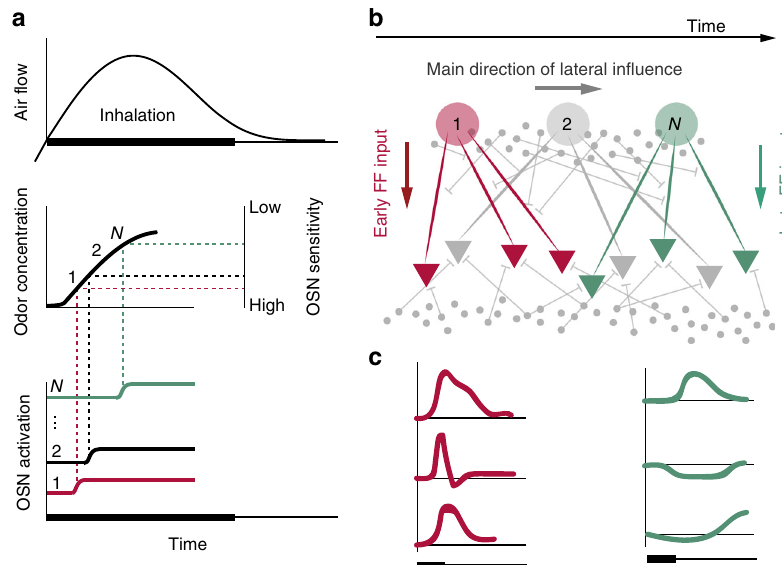
Fig. 8 A proposed mechanism responsible for stereotypy/diversity among sister MT cell odor responses. a In the presence of a given odor, OSN receptors ’ relative sensitivities to the odorant determine the relative response latencies of their corresponding glomeruli. As inhalation carries the odor into the nose (top), odor concentration rises gradually (middle, left). More sensitive olfactory receptors reach their activation threshold earlier (middle, right), and thus respond earlier (bottom). The labels 1 to N denote the temporal order of OSN channel activation. b The ensuing fl ow of activity in the bulb. The schematized olfactory bulb network is shown as in Fig. 1: glomeruli (large colored circles); MT cells (colored triangles); and inhibitory neurons (small gray circles; top = periglomerular layer, bottom = granule layer). Thin gray lines represent inhibitory connections. The glomeruli are depicted horizontally in the order of the temporal sequence of activation (1 to N ), as shown in a . MT cells connected to glomerulus 1 (red) receive early feedforward (FF) excitation, which propagates through the inhibitory network. MT cells connected to glomerulus N (green) receive both FF excitation and lateral inhibition. c